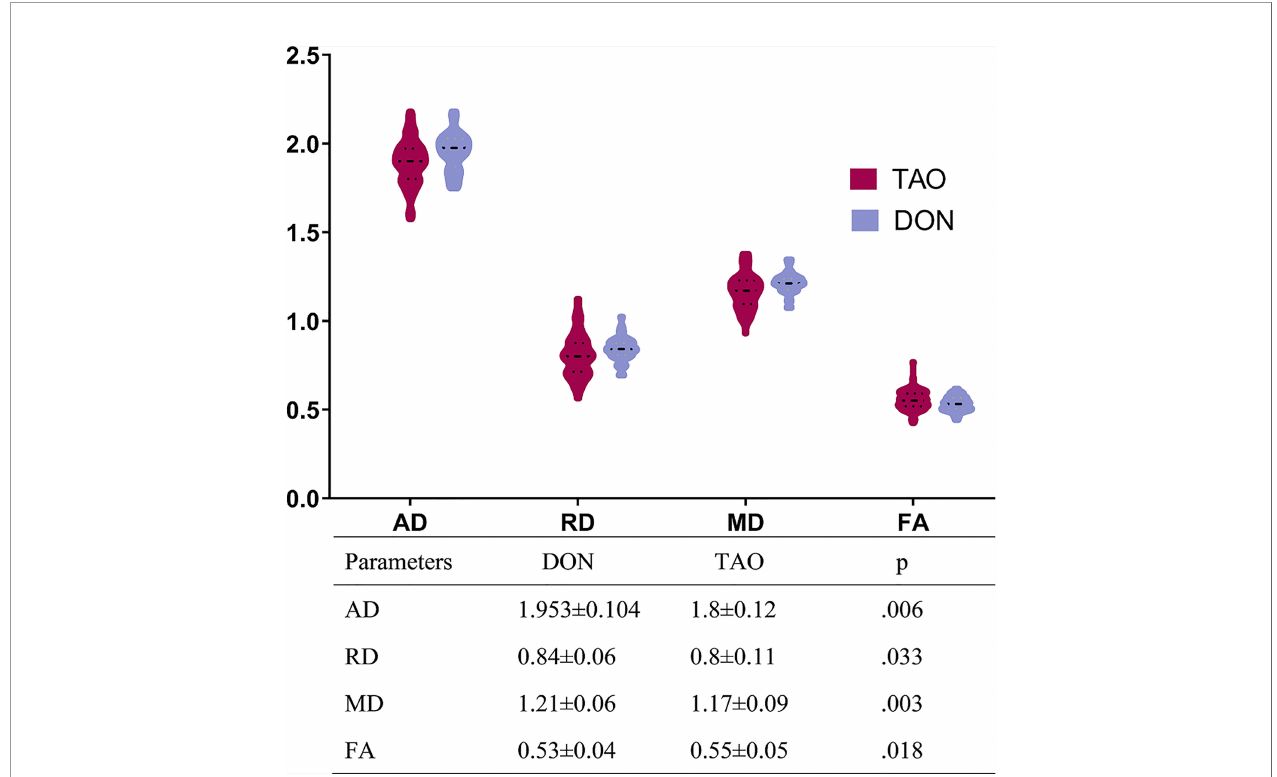
FIGURE 2 | Comparisons of all DTI parameters of optic nerve between DON and non-DON. The above bar chart showing the comparison of DTI parameters between the DON and non-DON groups. There is a trend toward higher fl uid AD, RD, and MD, but lower FA, in the DON group (p < 0.05, respectively). The table below displays the quantitative assessment of each DTI parameter. Units of MD, AD, and RD are x 10 -3 mm 2 /s. A p-value < 0.05 was considered statistically signi fi cant. TAO, Thyroid- associated ophthalmopathy; DON, Dysthyroid optic neuropathy; AD, axial diffusivit; FA, fractional anisotropy; MD, mean diffusivity; RD, radial